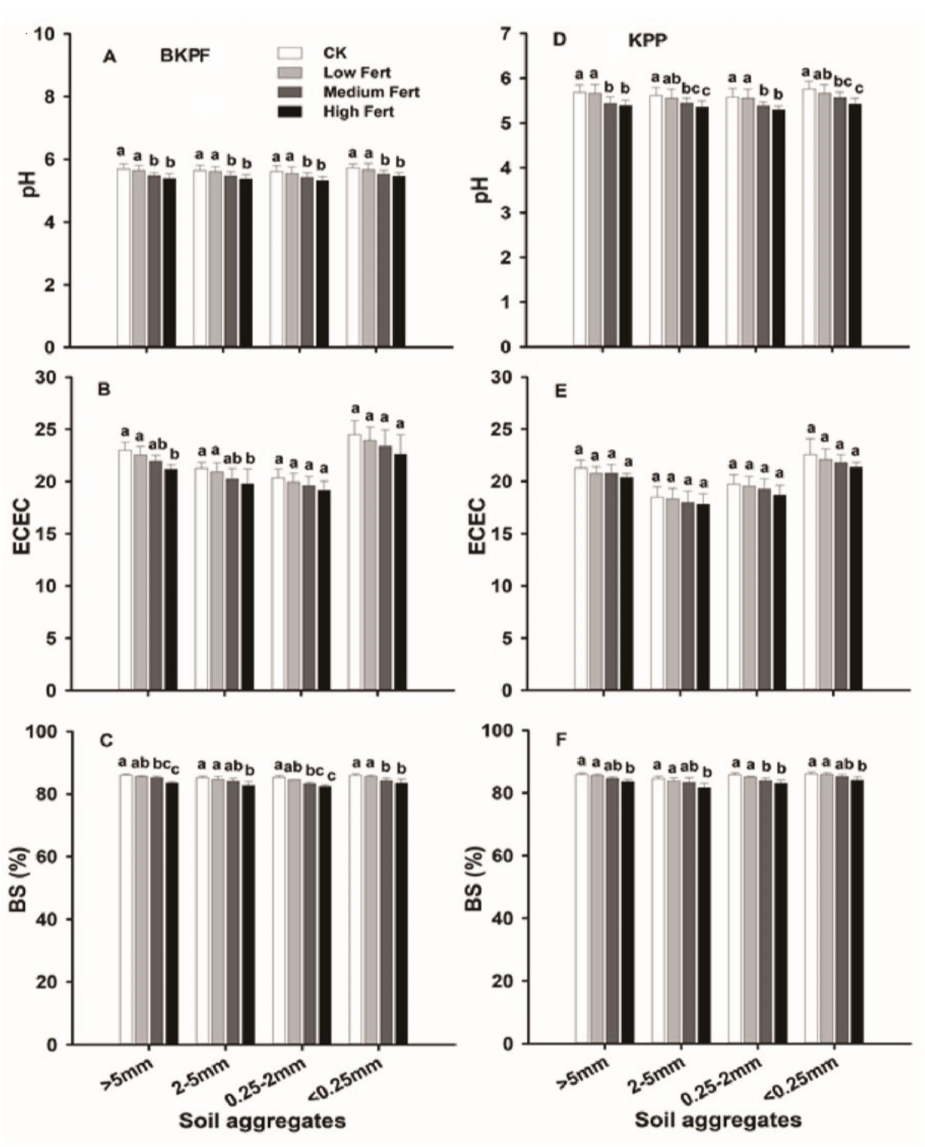
Figure 2. Soil pH (pH) ( A , D ), effective cation exchange capacity (ECEC) ( B , E ), and base saturation percentage (BS%) ( C , F ) at the control (C: no additional deposition; white bars) and after low NP: 05-g N m − 2 a − 1 + 05-g N m − 2 a − 1 ; light grey, medium NP: 15-g N m − 2 a − 1 + 10-g N m − 2 a − 1 ; dark grey, and high NP: 30-g N m − 2 a − 1 + 20-g N m − 2 a − 1 ; black fertilization in respective soil aggregates >5 mm, 2–5 mm, 0.25–2 mm, and <0.25 in three replications at 0–20 cm soil depth of mixed broad-leaved Korean pine forest (BKPF) and artificial Korean pine forest (KPP) in Northeast (NE) China. Significant differences between treatments are indicated by different lower-case letters (Tukey’s HSD post hoc; p < 0.05; mean ±